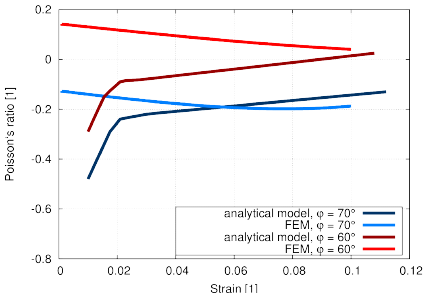
Figure 8. Comparison of Poisson’s ratio functions obtained from analytical model [7] and from the finite element analysis performed in this